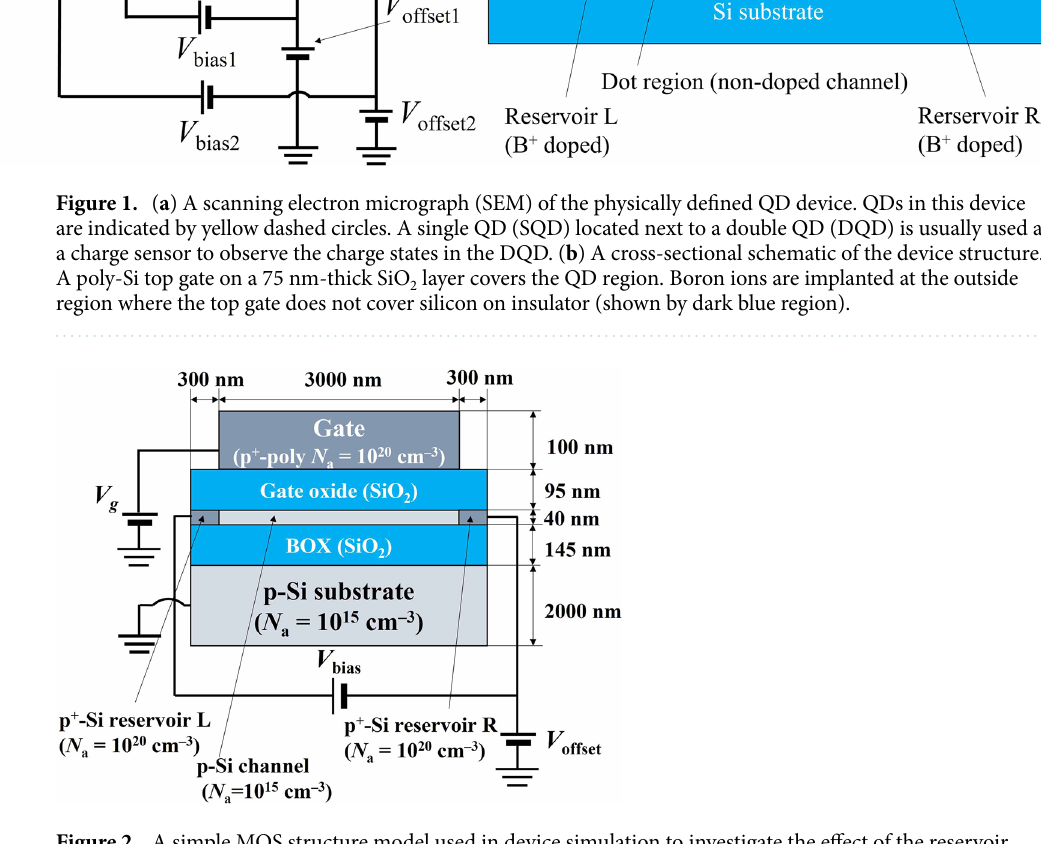
Figure 2. A simple MOS structure model used in device simulation to investigate the effect of the reservoir offset voltage on charge accumulation of Si channel qualitatively. This device is simulated at a temperature of 300 K, and the width of the channel is not defined for simplicity. The impurity concentration of each layer, indicated in the label, is chosen based on the actual